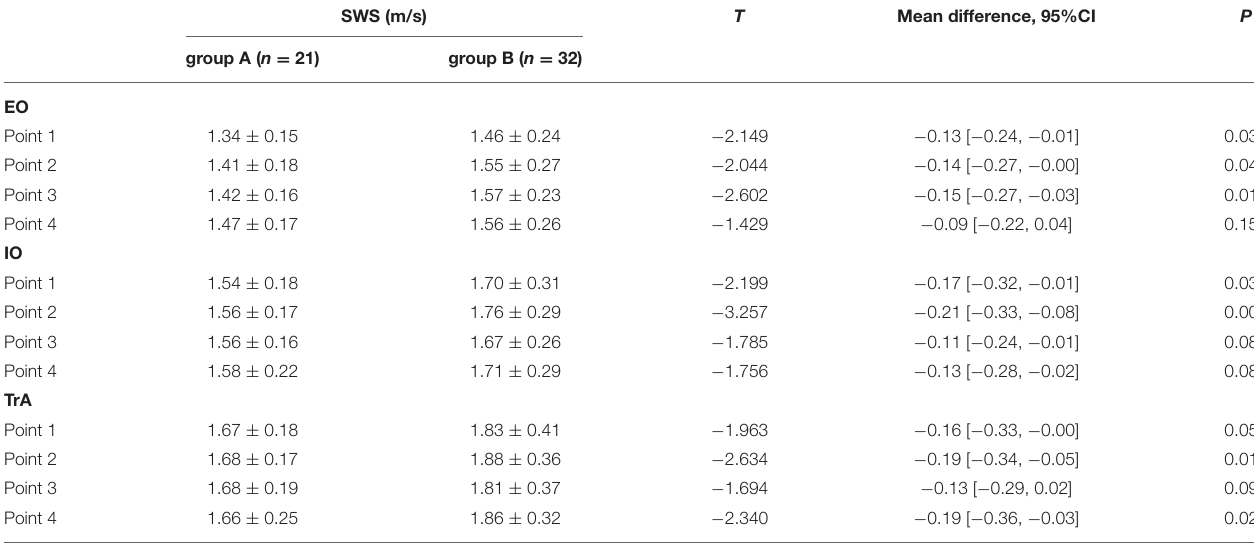
TABLE 4 | Comparison of shear wave speed between group A and group